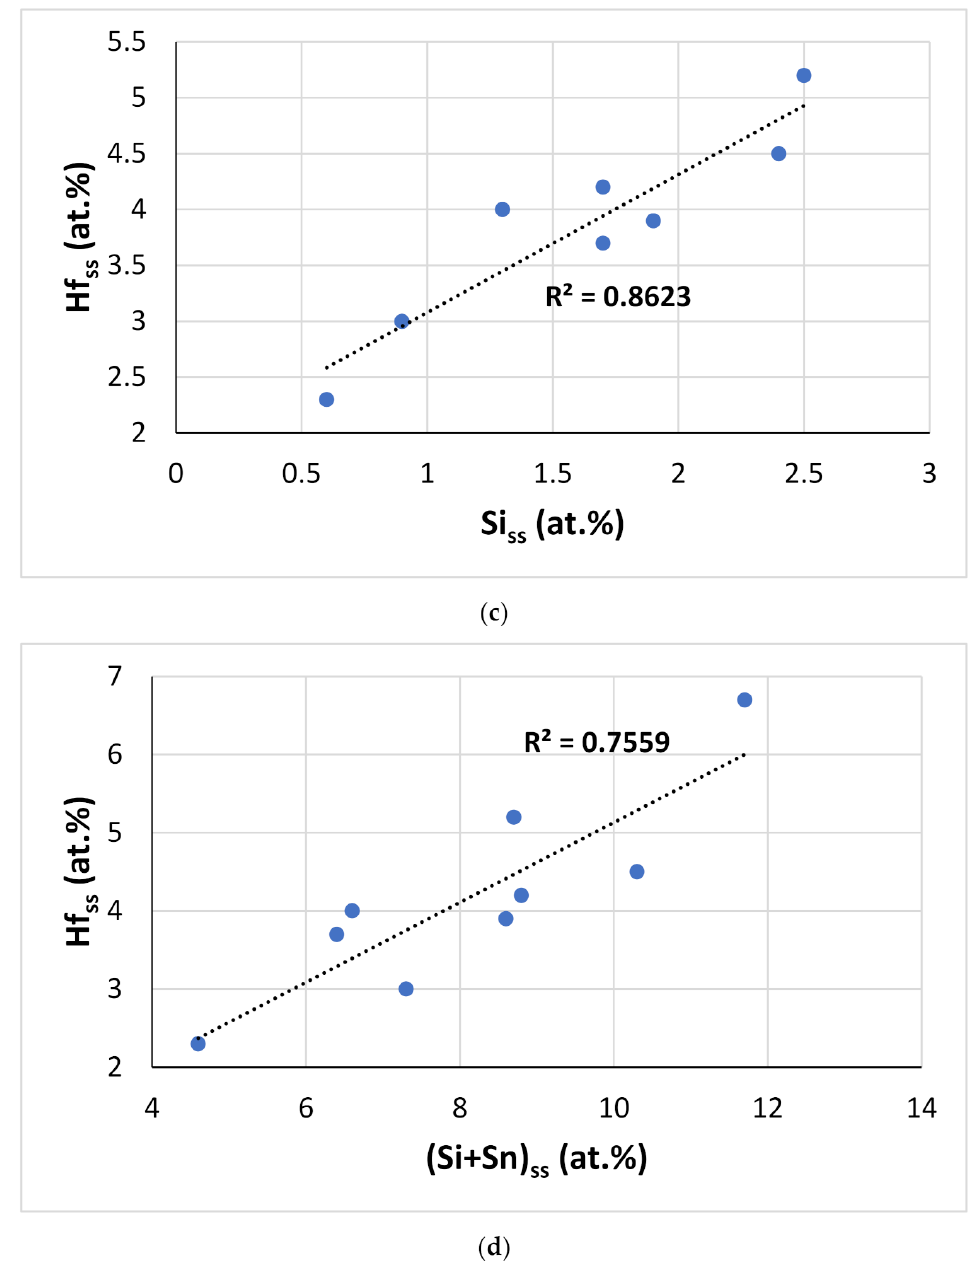
Figure 15. ( a ) Nb versus Ti + Hf, ( b ) Ti versus Hf, ( c ) Hf versus Si, and ( d ) Hf versus Si + Sn concentration in the Nb ss in the alloys of this